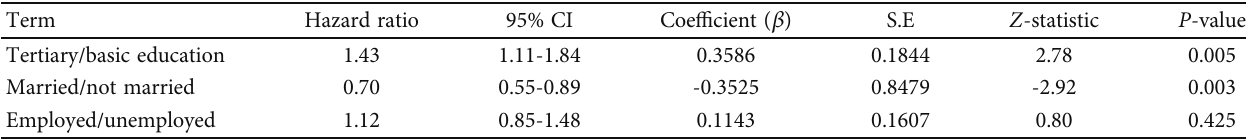
Table 4: Final Cox proportional hazard model with factors a ff ecting duration of exclusive breastfeeding in Yaoundé, Cameroon.